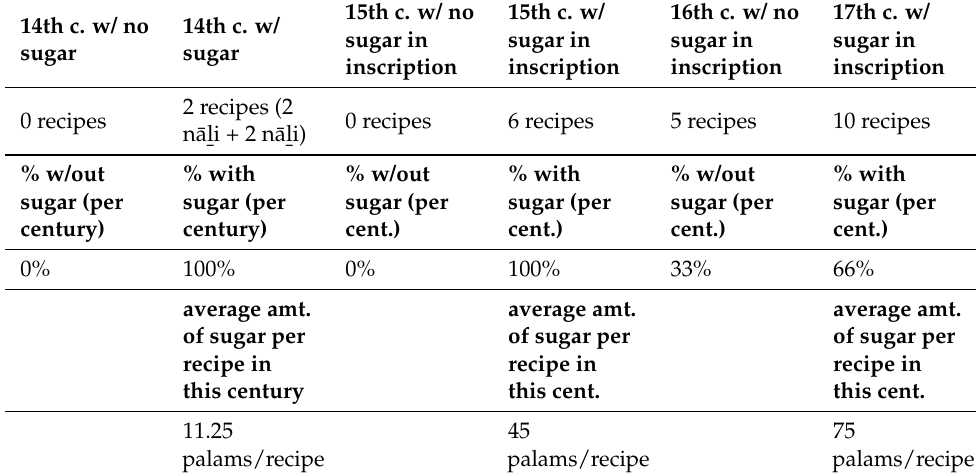
Table 4. Vijayanagara period data.